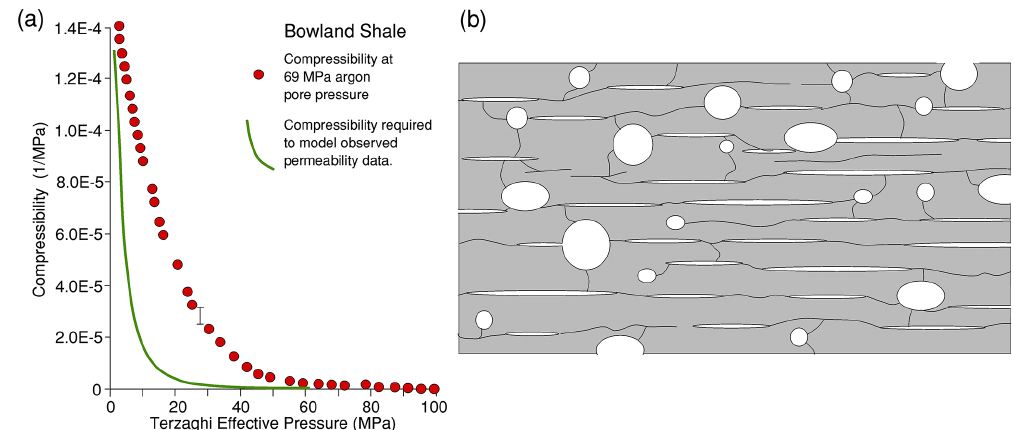
Figure 13. (a) The experimentally observed variation in pore compressibility at 69MPa pore pressure (filled circles) vs. Terzaghi effective pressure for Bowland shale, derived from the data in Fig. 9. The reciprocal of this compressibility is φ/K φ . This rate of reduction in compressibility with effective pressure cannot predict the observed pressure sensitivity of permeability that is observed experimentally. The continuous curve shows what the trend would have to be like in order that the single capillary tube model can behave in the same way as the rock. (b) Schematic illustration of the porosity model best able to explain the permeability and bulk modulus data in the shales. Highly eccentric pores and cracks lie parallel to layering but are well-connected, accounting for easy gas transport yet using only a small fraction of the porosity. These narrow pores are easily constricted by hydrostatic pressure. Most of the storage capacity resides in the larger, equant pores of dimensions of about 1µm that are poorly linked and not easily closed down by hydrostatic